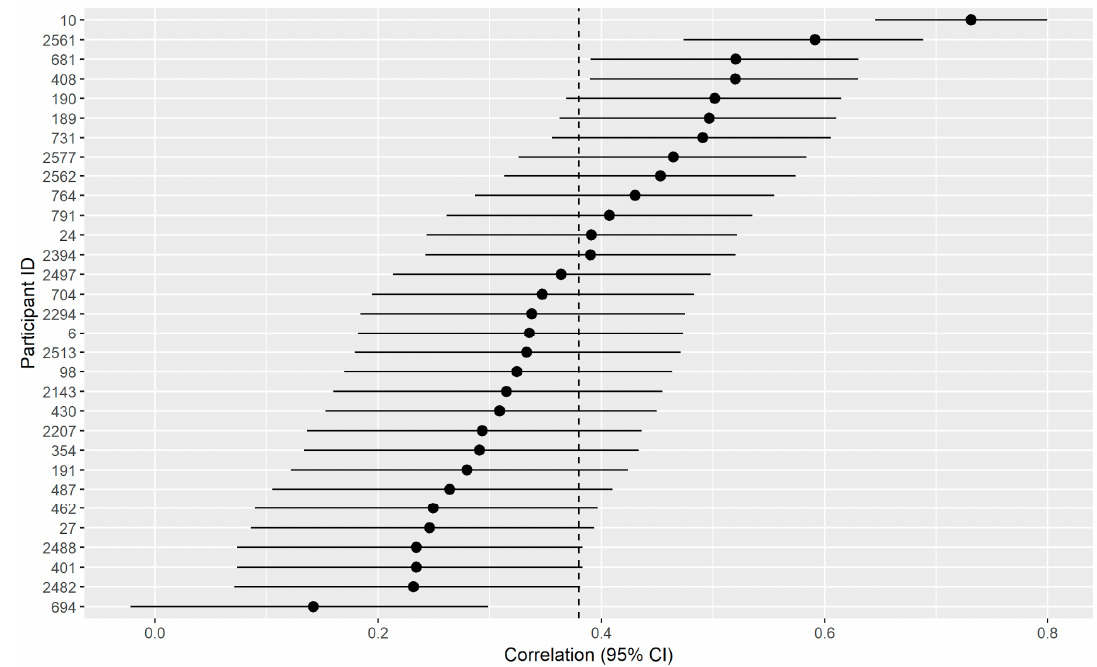
Figure 5. This figure depicts the hourly depressed mood for each subject. Here the red lines represent observed depressed mood points (and the average of the multiply imputed data points when there was missing data). The blue lines depict the predicted depressed mood based on the idiographically-weighted models.